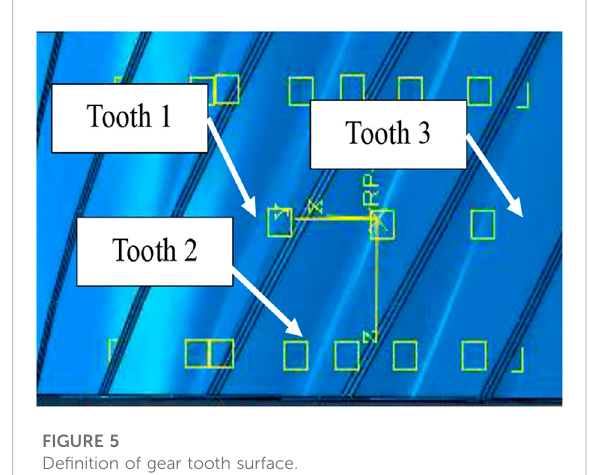
FIGURE 5 De fi nition of gear tooth